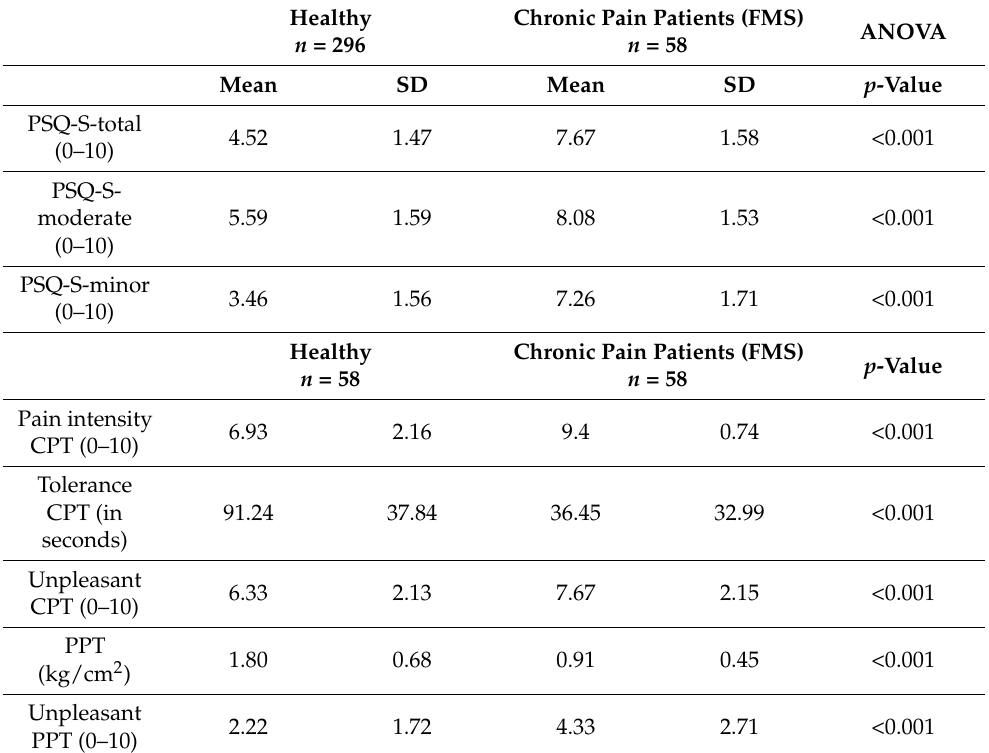
Table 5. Between-group differences in factor components of PSQ-S and the experimental pain sensitivity